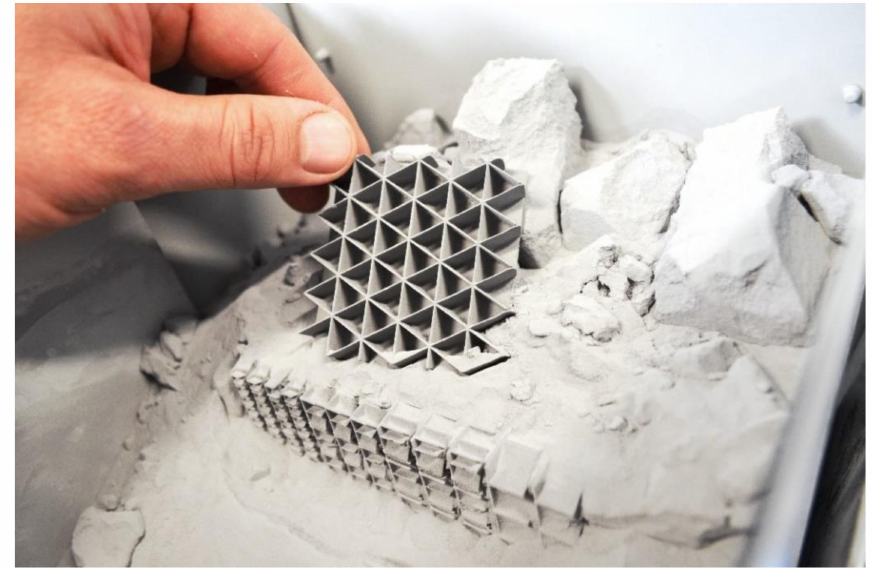
Figure 3. A single layer of a printed structure when being taken out of the 3D printer.